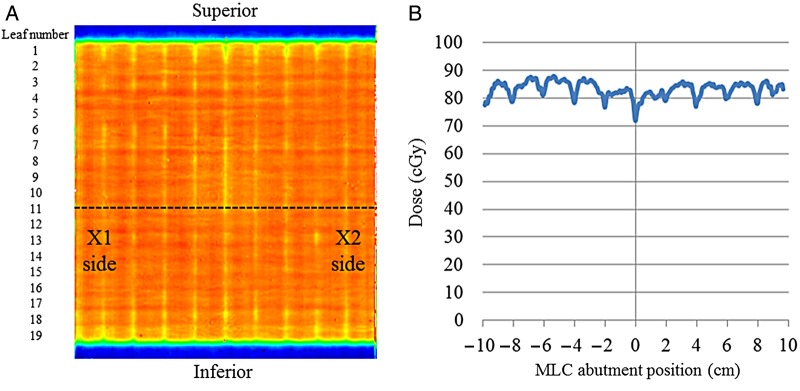
(A) Dose distribution for a non-gap test at a gantry angle of 0° using film. (B) The dose profile at leaf number 11 is shown by the dotted line in (A).